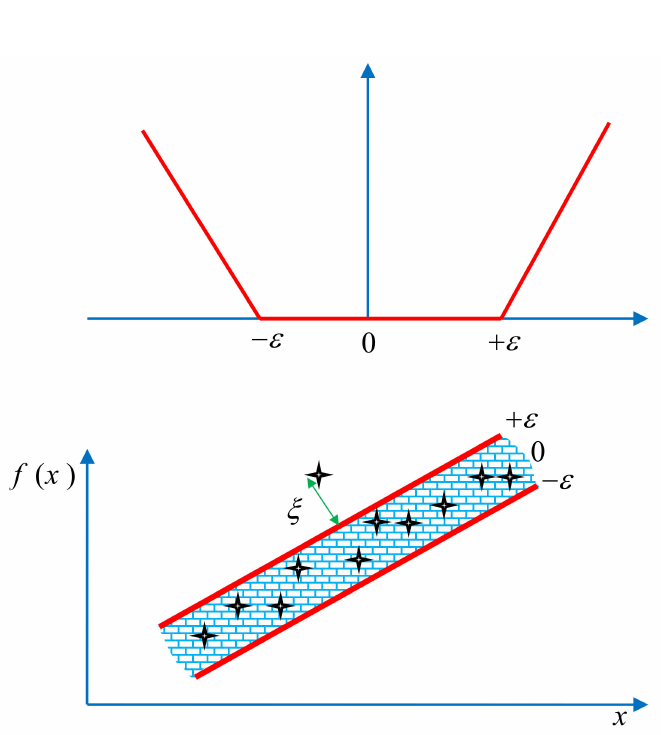
Figure 3. ( Top ) ε -insensitive waste function to estimate performance; ( bottom ) ε -tube